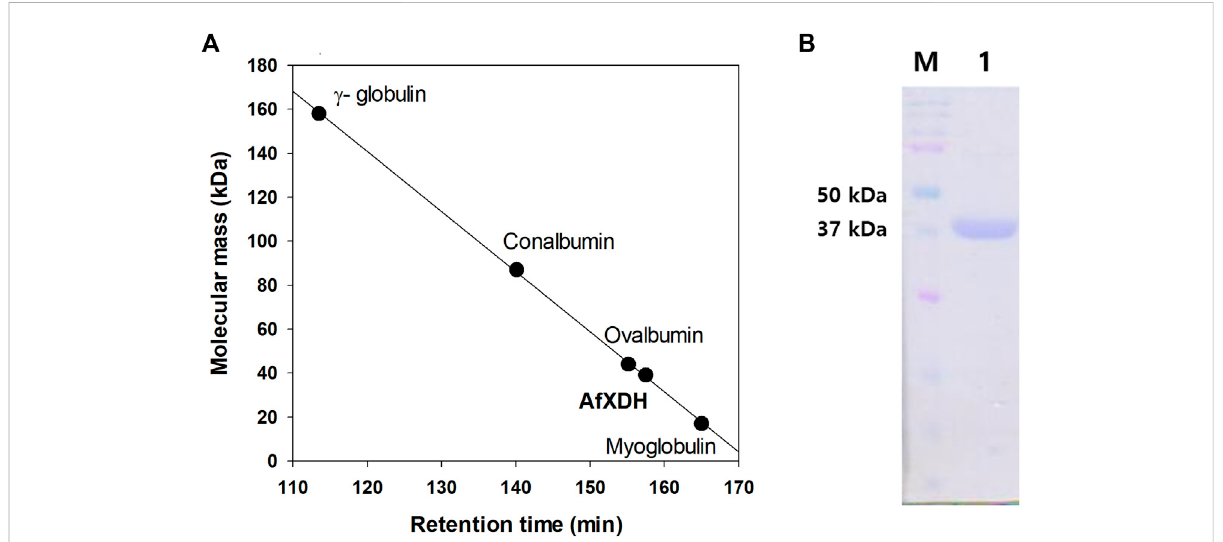
FIGURE 2 Determination of the molecular mass of A. fl avus XDH by gel fi ltration chromatography and SDS – PAGE. (A) Gel fi ltration chromatography of AfXDH. To determine the molecular mass of AfXDH, the column was calibrated with γ - globulin (MW 158,000), conalbumin (MW 87,000), ovalbumin (MW44,000),andmyoglobin(MW17,000)asreferenceproteins(GEHealthcare,UnitedKingdom). (B) SDS – PAGEofAfXDH.LaneM,Molecularmass Marker; Lane 1, puri fi ed recombinant